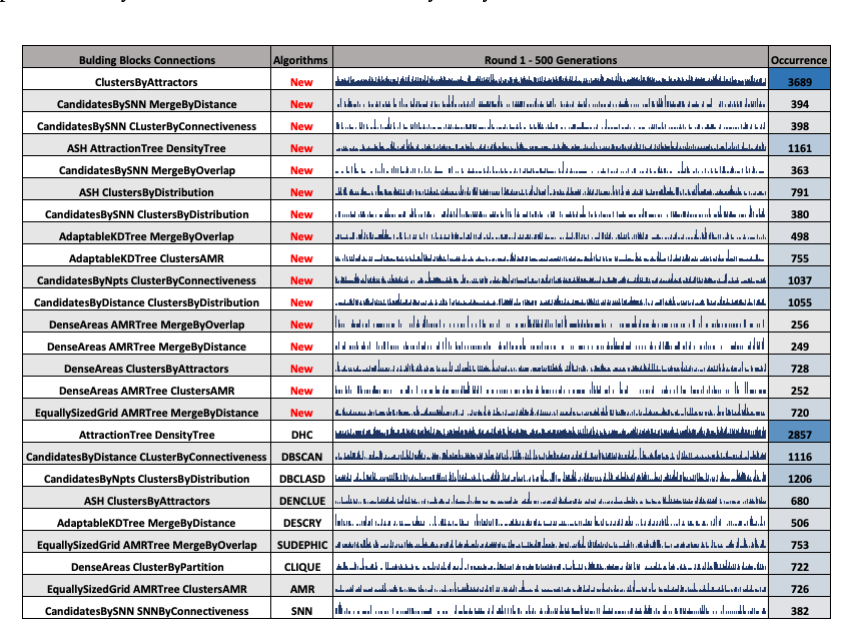
Figure 3. Histograms of total occurrences of blocks in each of the 500 generations considering a single